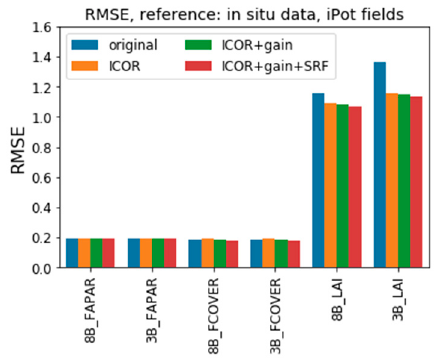
Figure 6. Mean bias error (MBE) (left) and RMSE (right) for the different BIOPARs (X-axis) and for the different correction combinations (colors).